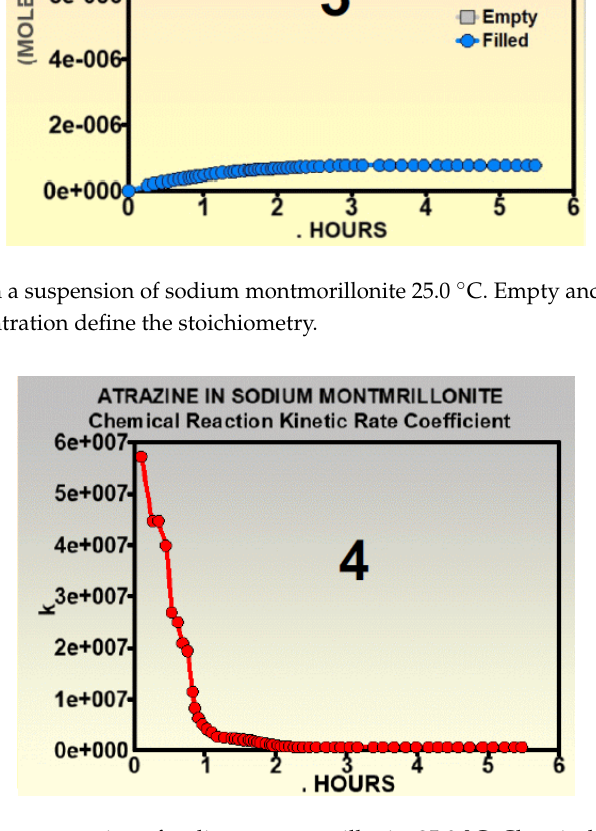
Figure 4. Atrazine in a suspension of sodium montmorillonite 25.0 °C. Chemical reaction. First order kinetic rate coefficient.